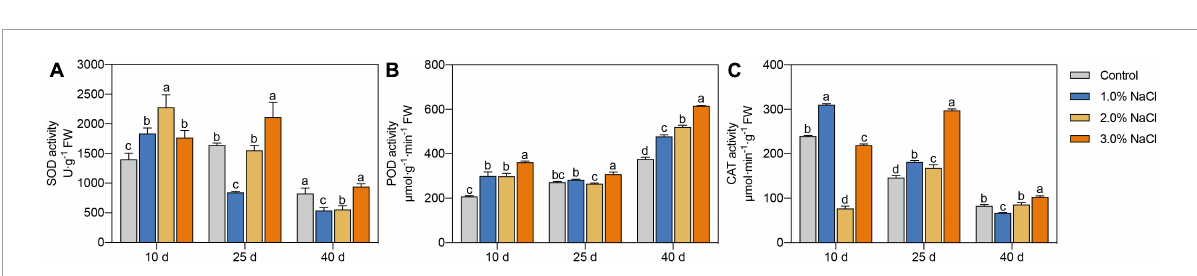
FIGURE2 (A–C) Effects of 0, 1.0, 2.0, and 3.0% NaCl on antioxidant enzyme activities of S. caseolaris seedlings. Values are means ± SD ( n = 3). Values with a different letter within a sampling date are significantly different ( P < 0.05).